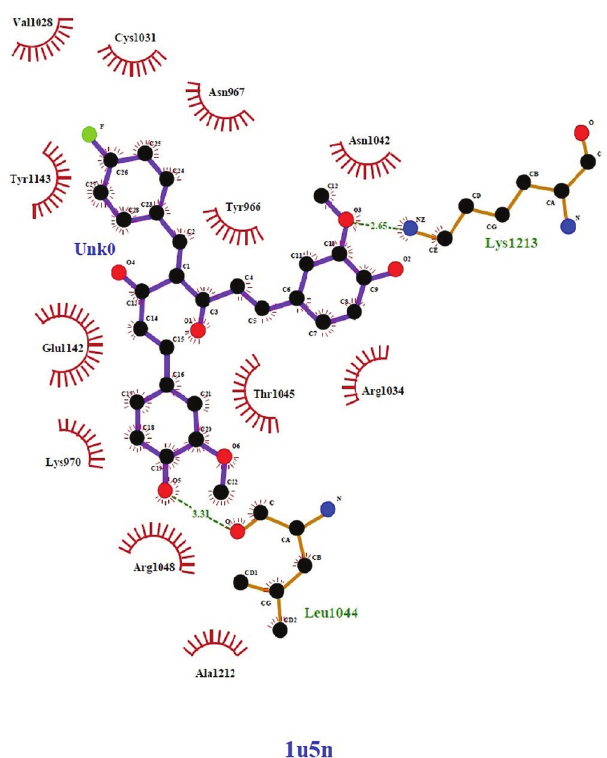
FIGURE 8 - 4-FB docking